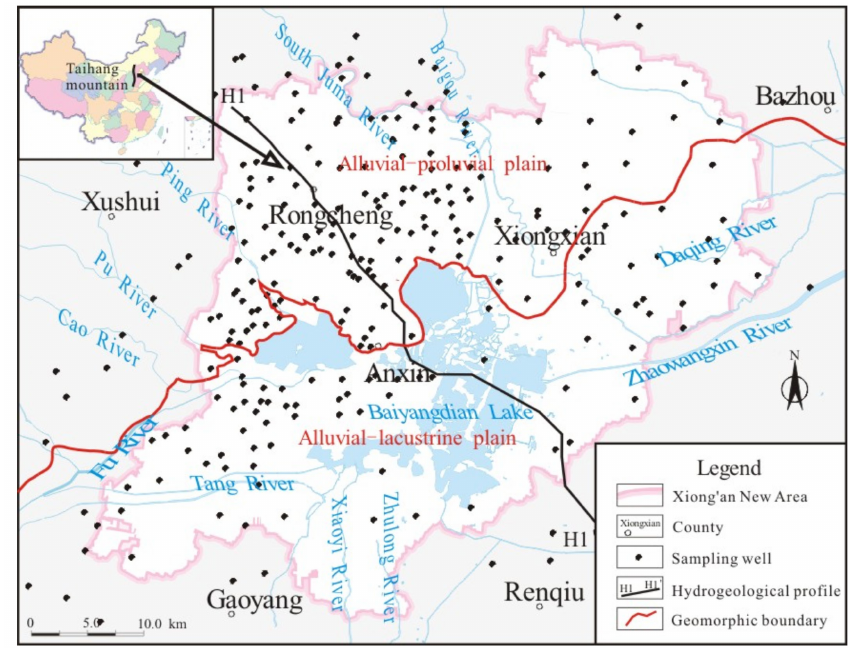
Figure 1. Location of sampling points and the hydrogeological profile in the study